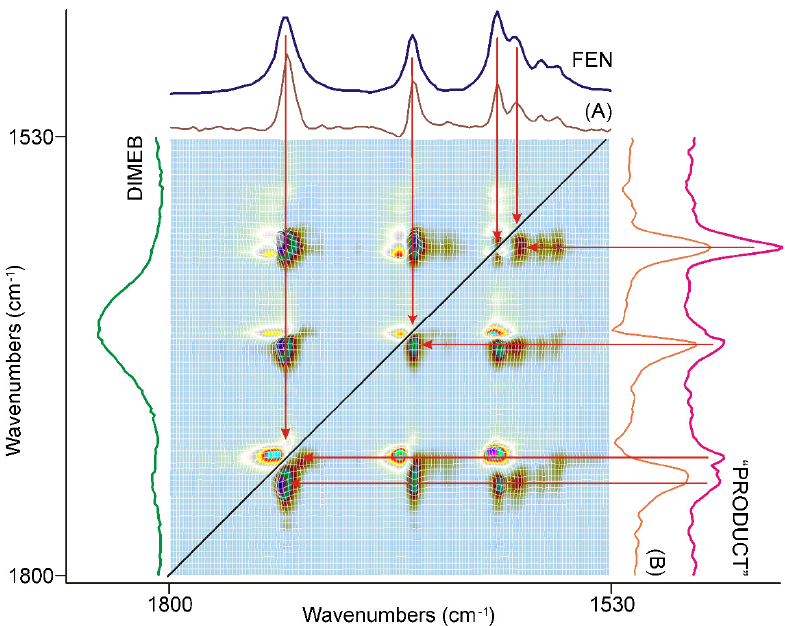
Figure 8. The asynchronous correlation surface calculated from the spectra recorded during the second 20 min of grinding was free of the interference of residual water vapor peaks and showed real asynchronous processes. The positions of the off-diagonal peaks were determined practically by the same wavenumbers as those of the diagonal peaks in the corresponding synchronous correlation surface. The x-axial section taken at 1740 cm − 1 (A) and at 1728 cm − 1 (B) showed that the positive sign of the off-diagonal peaks in the upper-left triangle were attributed to the peaks of FEN, and the same in the lower-right triangle to the peaks of “PRODUCT”, so the intensity changes in this region had an asynchronous component above the synchronous one, at the beginning of the period.